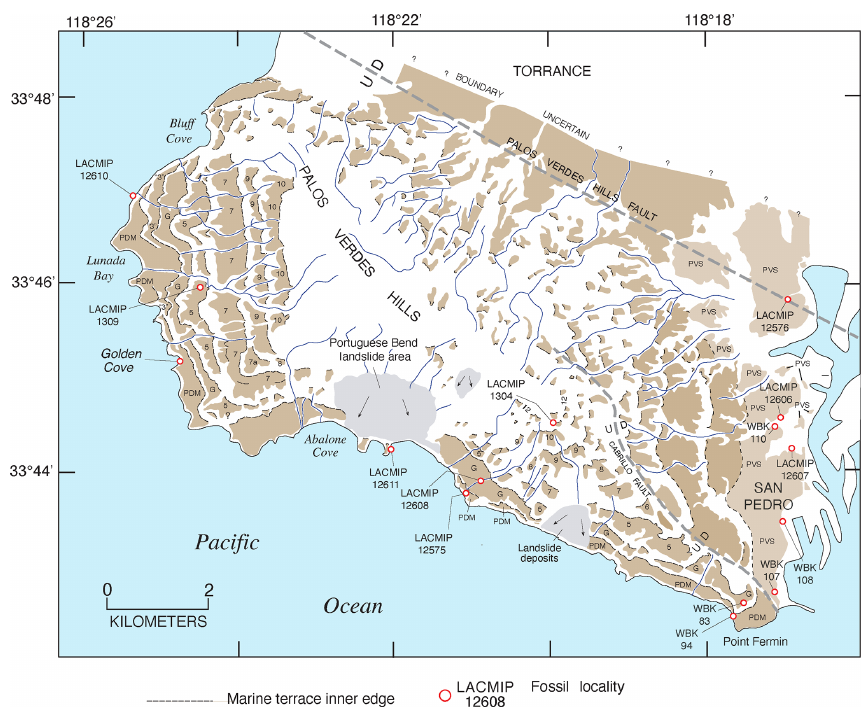
Figure 26. Map of marine terrace deposits (brown shades), terrace inner edges (black lines), fossil localities (open red circles), landslide deposits (gray shades), and faults in the Palos Verdes Hills area, Los Angeles County, California. Redrawn from Woodring et al. (1946). PVS: Palos Verdes Sand, part of which is of MIS 5e age (Muhs and Groves, 2018); PDM: Paseo del Mar terrace ( ∼ 80ka, MIS 5a); G: Gaffey terrace ( ∼ 120ka, MIS 5e; Muhs et al., 2006). LACMIP fossil locality numbers; WBK: fossil localities of Woodring et al. (1946).